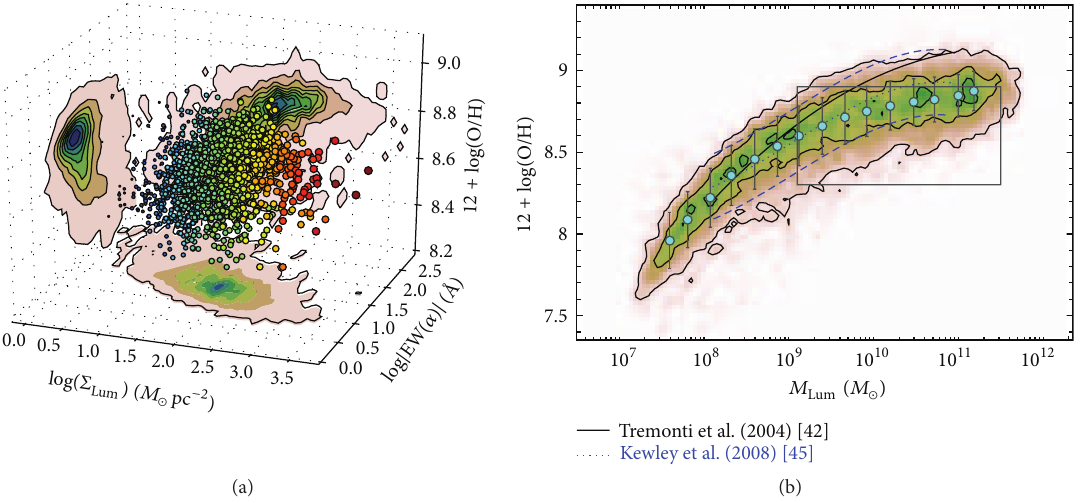
Figure 8: (a) 3D representation of the local M -Z-EW(H 𝛼 ) relation. The size and color scaling of the data points are linked to the value (i.e. low-blue to high-red values). The projection of the data over any pair of axes reduces to the local M -Z, M -EW(H 𝛼 ), and of log Σ Lum metallicity-EW(H 𝛼 ) relations. An online 3D animated version is available at http://tinyurl.com/local-mass-metallicity. (b) Distribution of simulated galaxies in the M -Z plane assuming a local M -Z relation and considering the aperture effect of the SDSS fiber, as explained in the text. The contours correspond to the density of points, while the circles represent the mean value (plus 1 𝜎 error bars) in bins of 0.15 dex. The black line stands for the [42] fitting, while the blue lines correspond to the Kewley and Ellison [45] ± 0.2 dex relation. The rectangle encompasses the range in mass and metallicity of the galaxy sample. Figure is adapted from Rosales-Ortega et al.